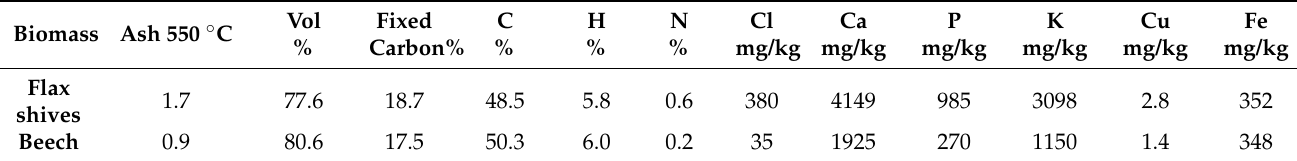
Table 1. Composition of the beech residues and flax shives (ultimate analysis and main inorganic elements).